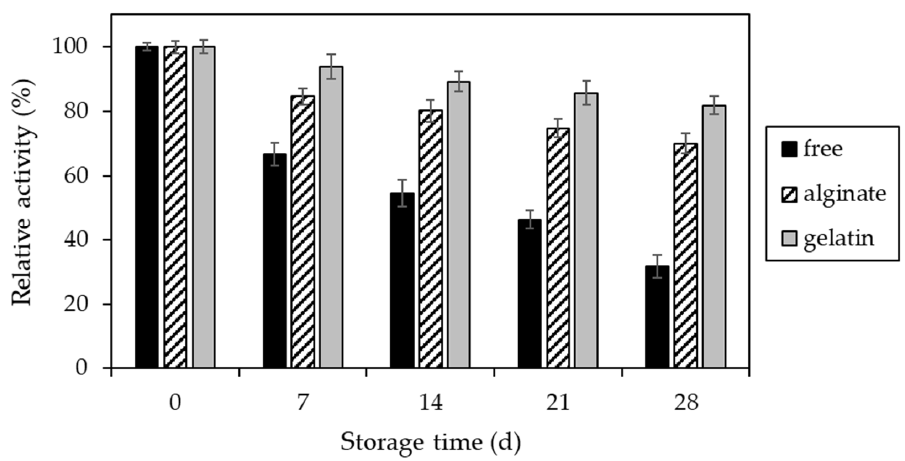
Figure 10. Storage stability of free invertase (black) and immobilized in alginate (striped) and gelatin-based hydrogels (grey) over 28 days of storage at 4 °C. The value of activity obtained on the beginning of storage (day 0) was assumed to be 100%.